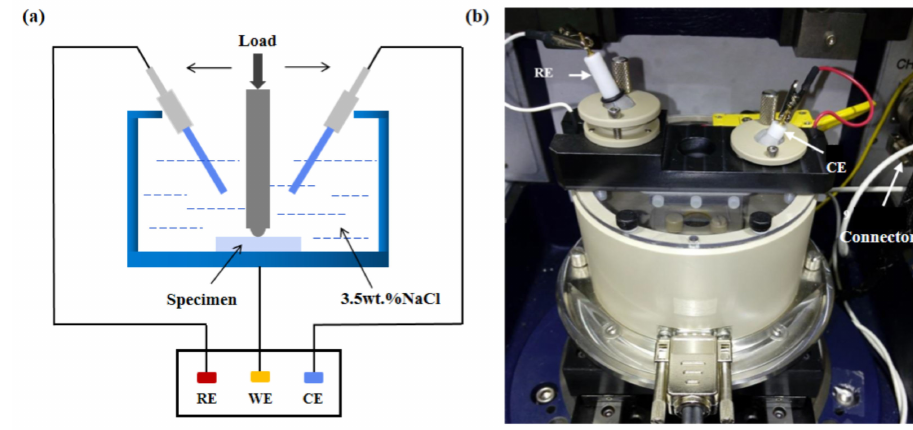
Figure 1. Schematic view ( a ) and some components ( b ) of the tribocorrosion tester. Samples were mounted at the bottom of the electrochemical cell including an elec- trolyte and a three-electrode system. The CoCrNi sample is used as the working electrode with an exposure area of 1 cm 2 while count electrodes (CE) and reference electrodes (RE) are platinum wire and Ag/AgCl (saturated KCl solution). All friction tests (with and without corrosion) were carried out under a fixed load of 4 N, a sliding frequency of 0.5 Hz, and a stroke length of 1 mm for 40